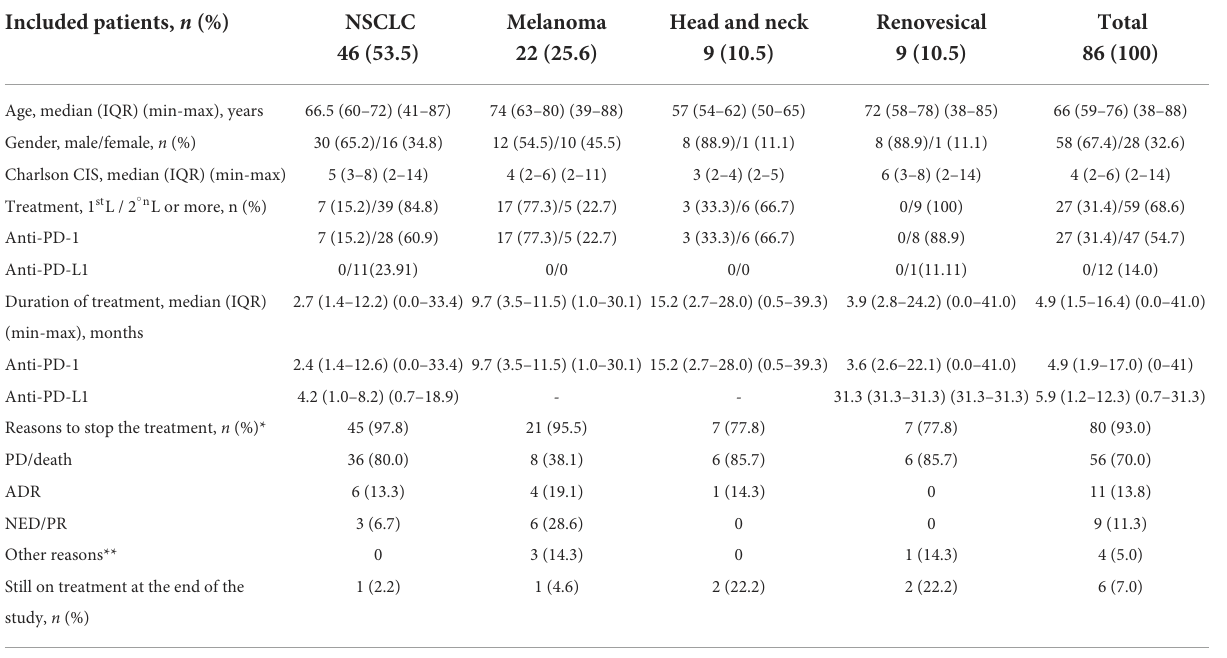
TABLE 1 General characteristics of